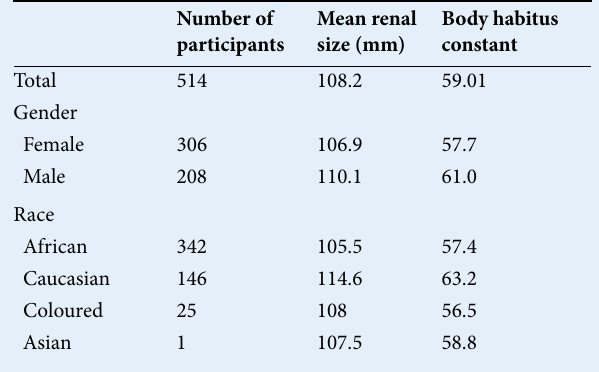
Table I. Mean renal size and body habitus constant related to gender and